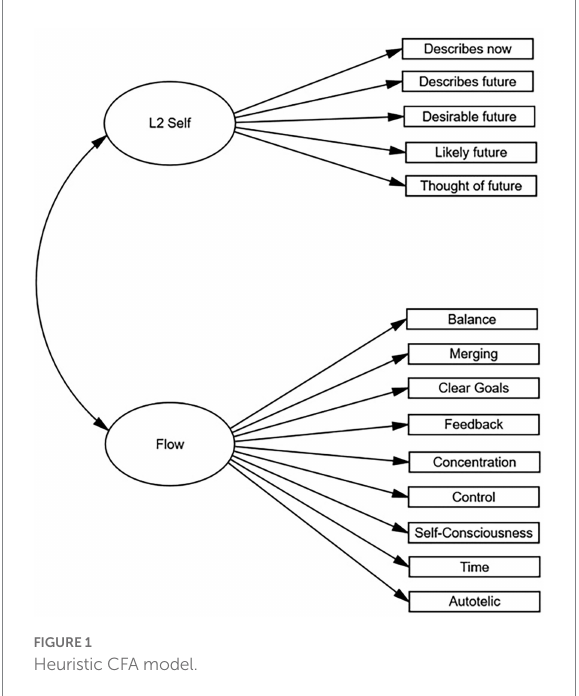
FIGURE 1 Heuristic CFA